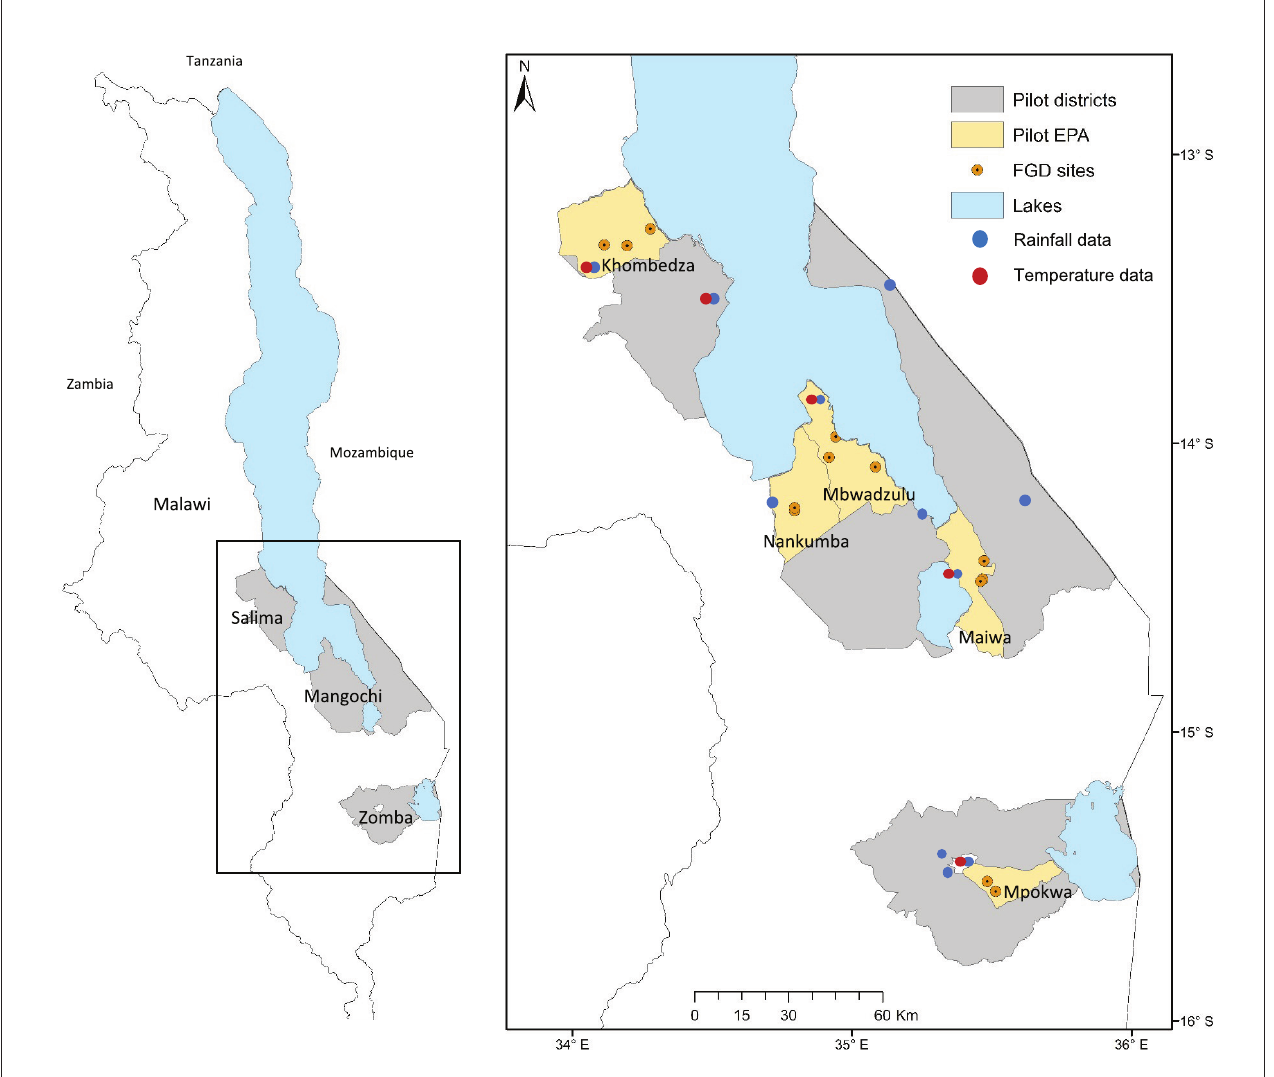
FIGURE 1 | Location of Salima, Mangochi, and Zomba districts in central and southern Malawi (left), highlighting selected Extension Planning Areas (EPA), focus group discussion (FGD) locations, and the availability of rainfall and temperature observational data within these districts (right).